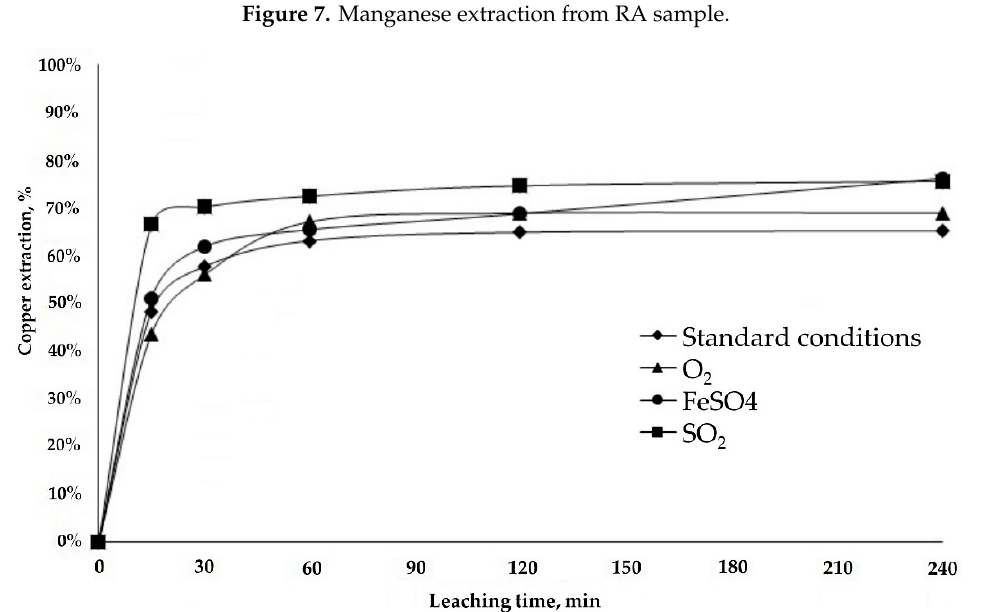
Figure 9. Manganese extraction from LB sample. According to the results and the literature, black copper resists leaching under standard and oxidizing conditions. The addition of a reducing agent increases copper and manganese extraction rates because of the rupture of the Cu-Mn matrix, which increases copper extraction from copper wad. Our results concur with those of [12], who indicated that SO 2 plays an important role in the dissolution of Mn from MnO 2 in accordance with the following reaction MnO 2(s) + SO 2(aq) → Mn 2+(aq) + SO 2 − 4 (aq)